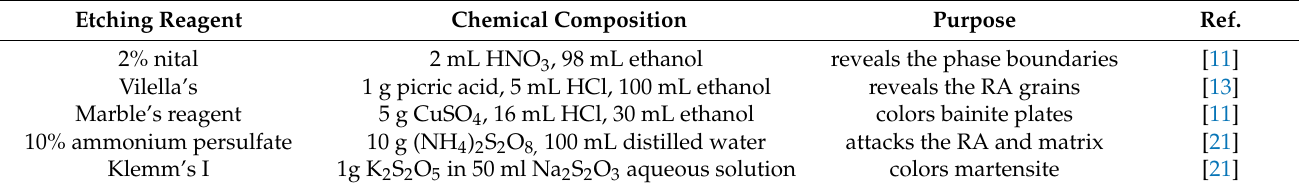
Table 2. Various tint etching reagents used in this research work.